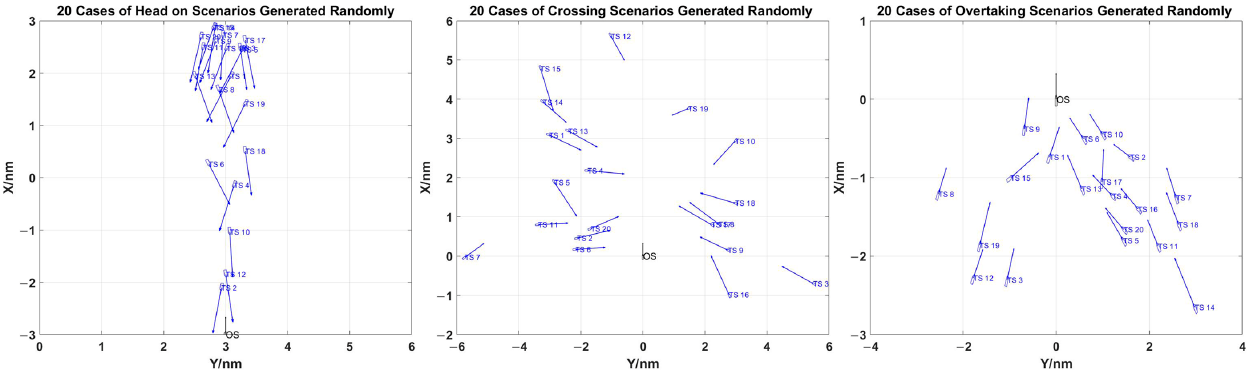
Figure 10. The initial 20 cases of each encounter generated randomly according to TS possibility distributions in real AIS data.